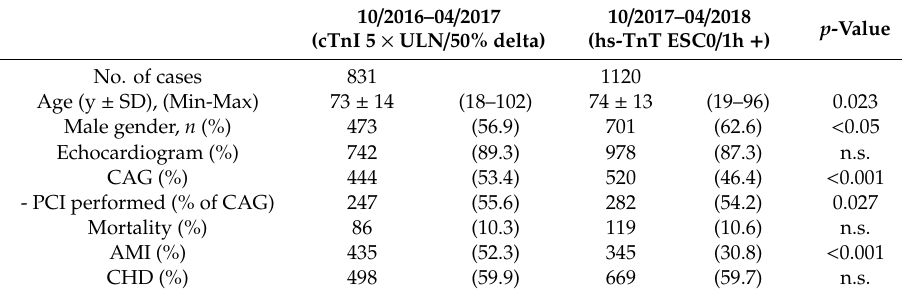
Table 4. Demographic and hospital data for inpatients of the cardiology department with single cTnI > 0.25 ng / mL ( = 5 × upper limit of normal) or 50% dynamic change between two measurements in the timeframe from 10 / 2016 to 04 / 2017 (cTnI 5 × ULN / 50% delta) and hs-TnT ≥ 52 ng / L or